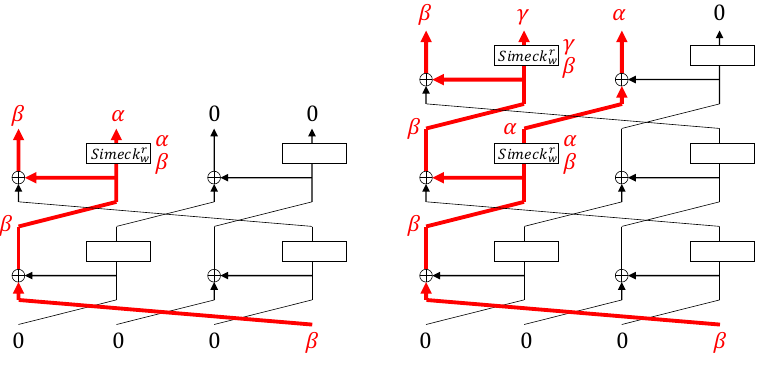
Figure 7: Left: the First Step of the 15-Step Attack for sLiSCP-light . Right: the First Two Steps of the 16-Step Attack for sLiSCP-light